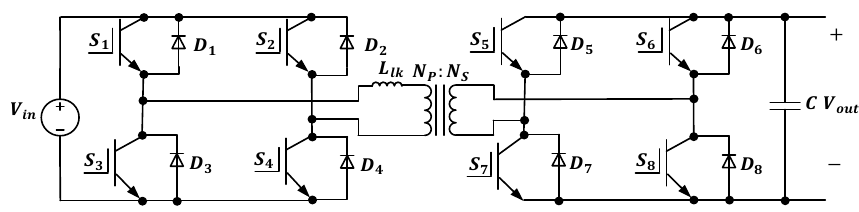
Figure 11. Dual Active Bridge (DAB) converter circuit diagram.